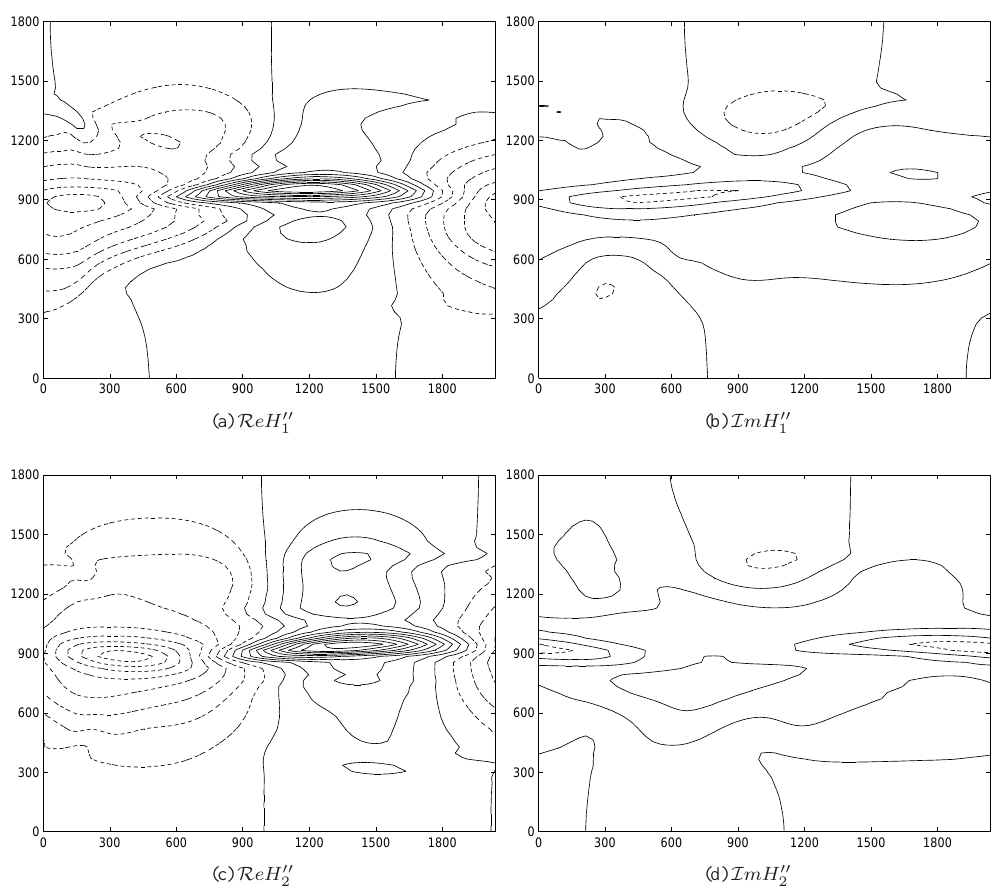
Fig. 7. Atmospheric stream function patterns spanning the oscillatory instability at the first two Hopf bifurcations. These patterns correspond to the (a, c) real and ( b, d) imaginary part, respectively, of the atmospheric component of the eigenvectors associated with (a, b) H 00 1 and (c, d) H 00 2 ; H 00 1 and H 00 2 are marked with a circle in Fig. 5. Contours as in Fig.